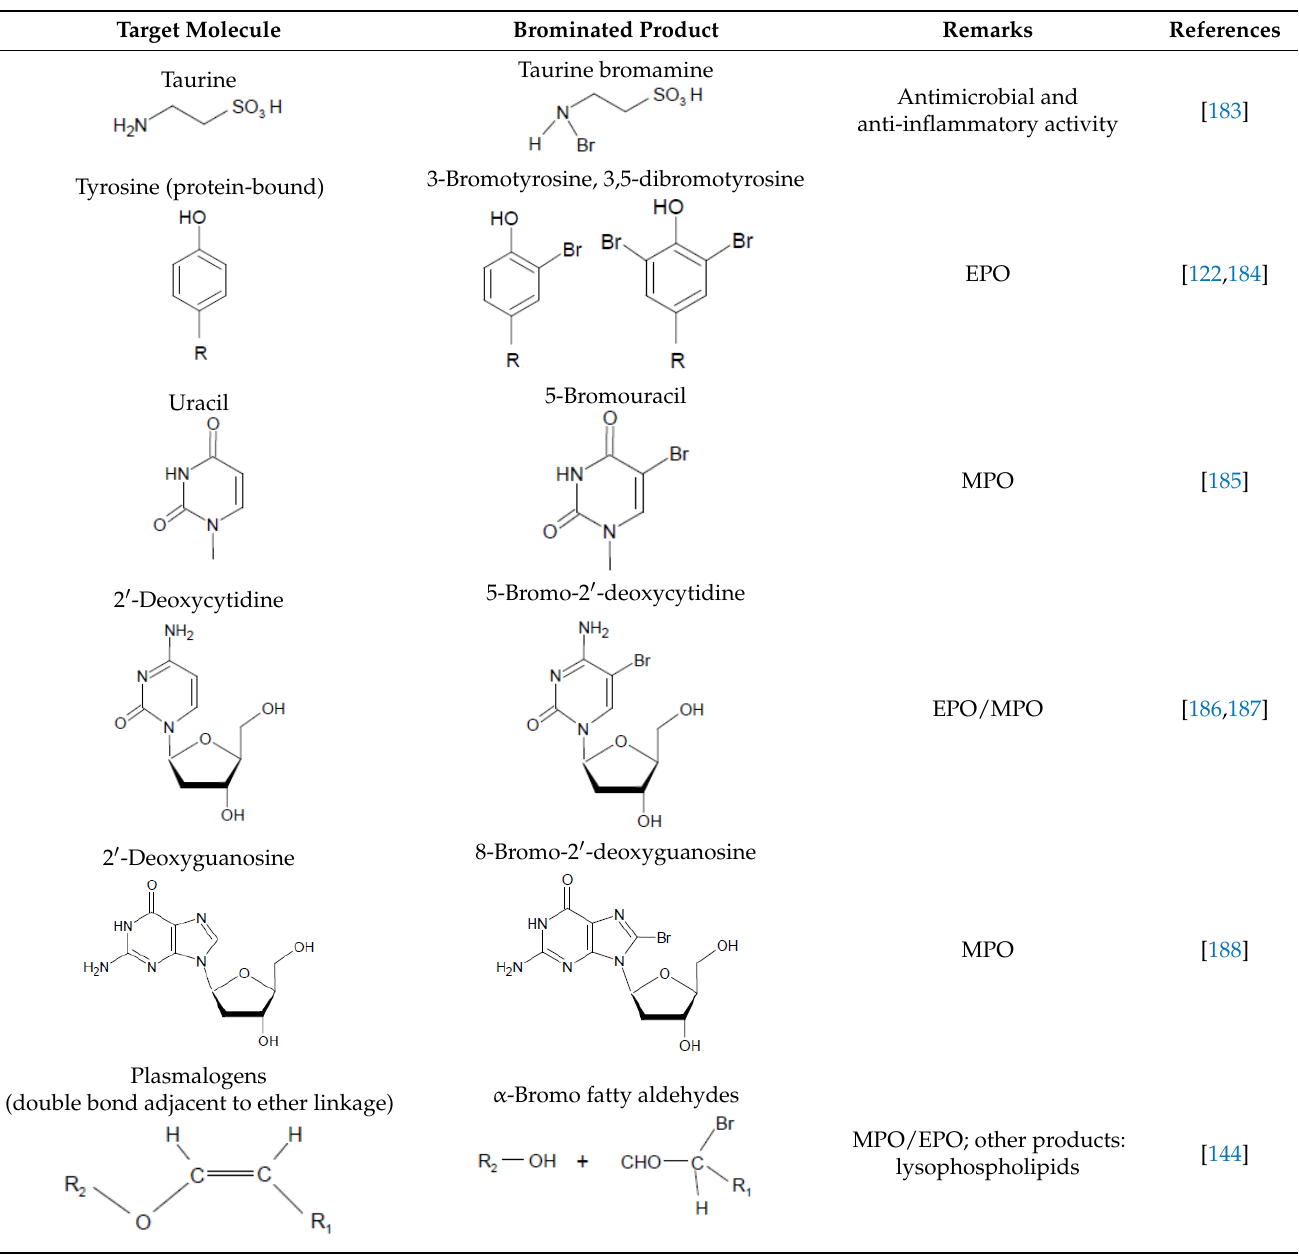
Table 1. Formation of physiologically relevant heme peroxidase-mediated brominated products.